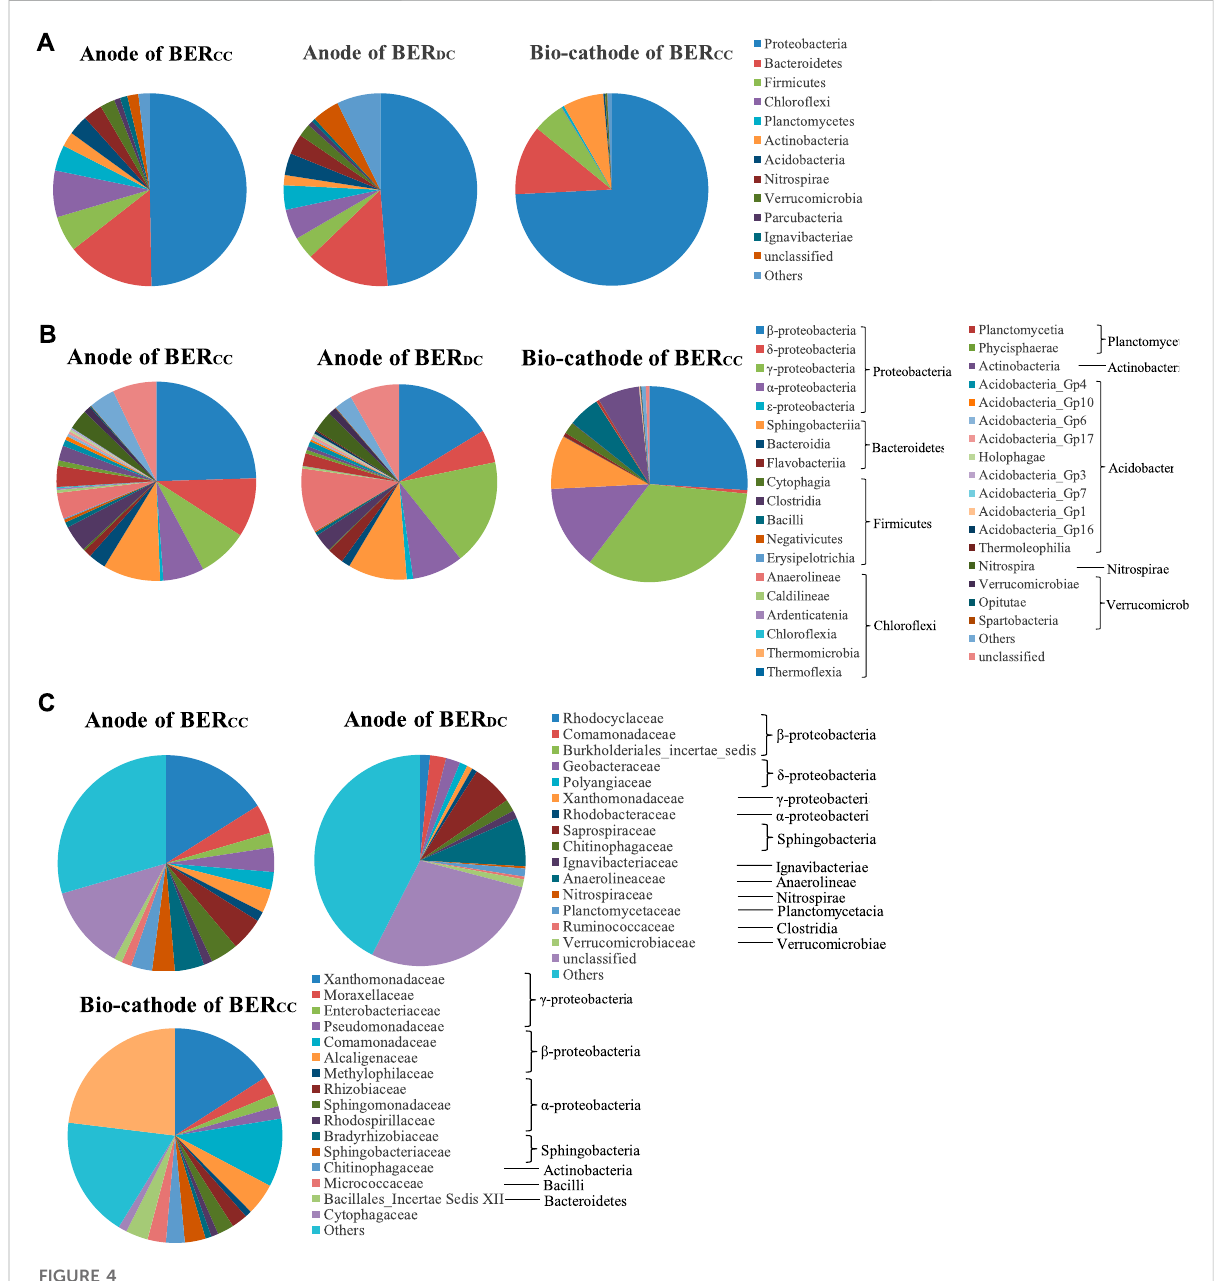
FIGURE 4 Relativeabundances(%)ofbio fi lmbacteriaontheanodeandthebio-cathodeofBER CC andtheanodeofBER DC atthephylum (A) ,class (B) ,and genus levels (C)